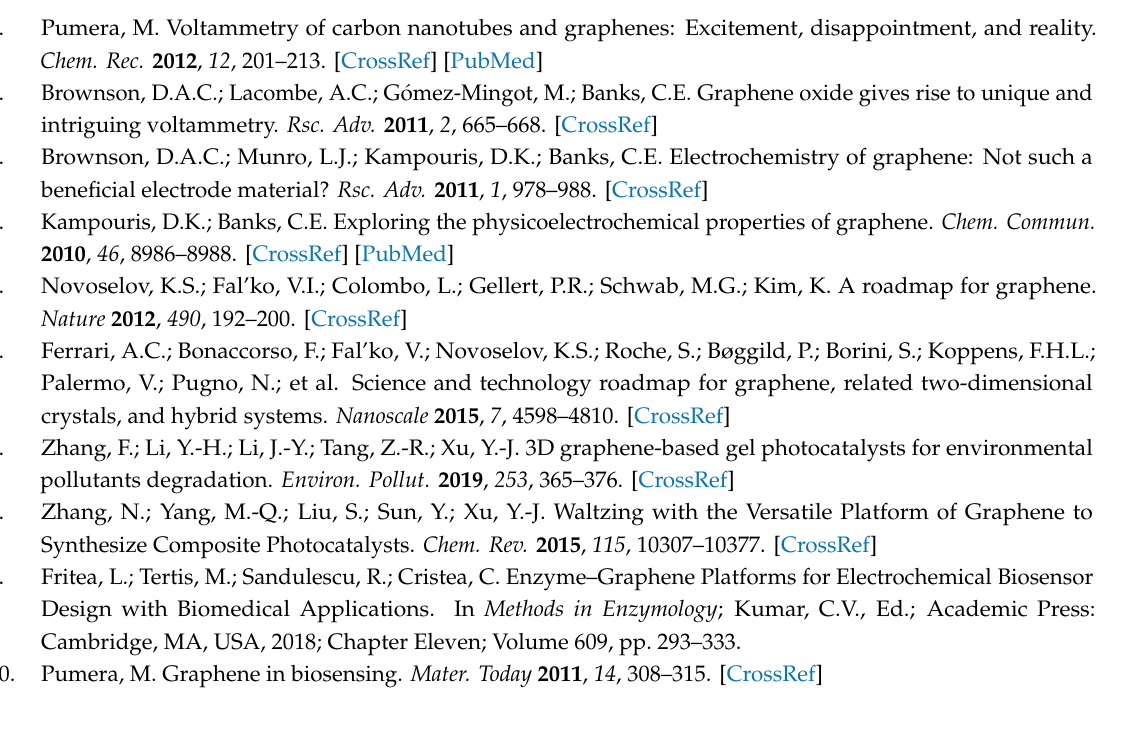
bu ff ers; Table S2: Summary of the immobilization